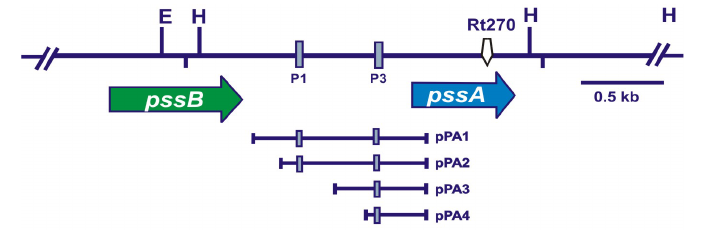
Figure 1. Physical and genetic map of the genomic region of Rhizobium leguminosarum bv. trifolii 24.2 carrying pssB and pssA genes. The green and blue arrows below the map show the direction of transcription of pssB and pssA , respectively. E, Eco RI, H, Hin dIII. P1 and P3 are promoter sequences for the pssA gene. Lines below the arrows indicate fragments of the pssA regulatory region cloned upstream of lacZ , which are present in individual pssA-lacZ transcriptional fusions